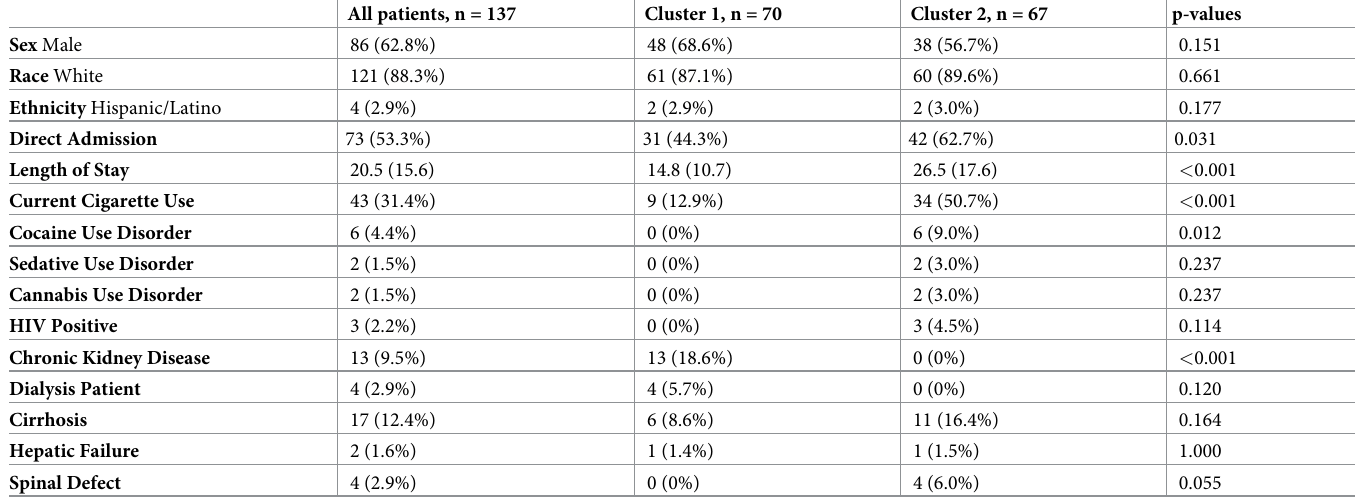
Table 1. Characteristics of participants with spinal epidural abscess, 2015 to 2019 � .